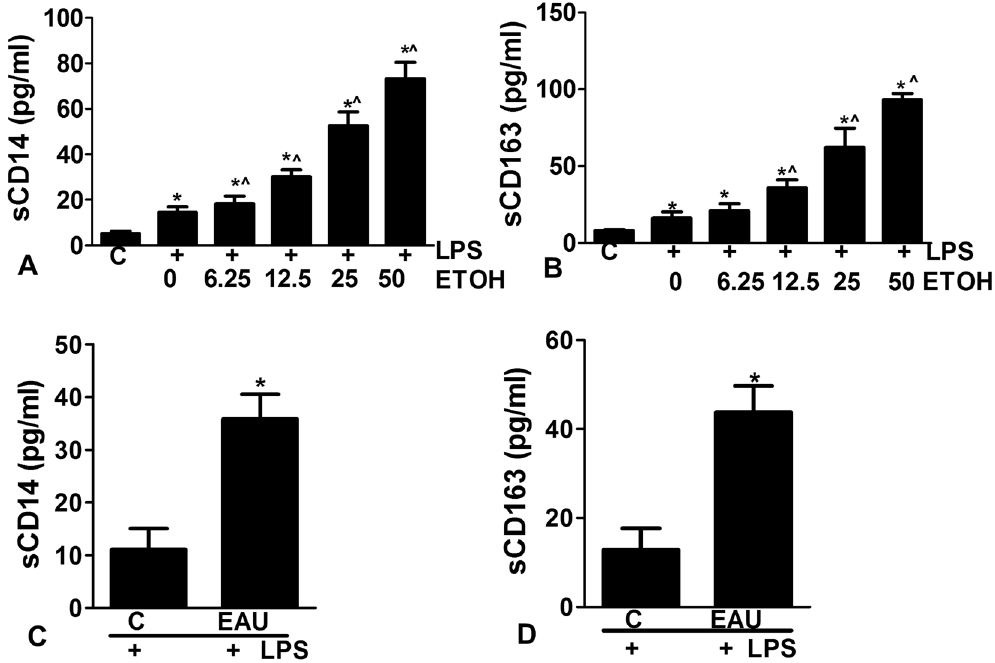
Figure 2. ( A , B ) Peripheral blood mononuclear cells (PBMCs) were isolated from healthy controls ( A and B ) and pre-treated with ethanol ranging from 6.25 mM–50 mM (1.4 mg–10 mg%) followed by treatment with LPS (10 ng/ml for 6 hrs). Ethanol primes PBMCs for LPS-induced inflammatory responses, as indicated by the increase in the levels of sCD14 and sCD163 in the supernatant in the dose dependent manner. ( C , D ) PBMCs were isolated from excessive drinkers and subjected to the stimulation with LPS (10 ng/ml for 6 hrs). sCD14 and sCD163 were significantly increased in supernatants of LPS stimulated PMBCs from subjects with EAU compared to controls. * Compared to controls and ^compared to LPS treatment alone, p <